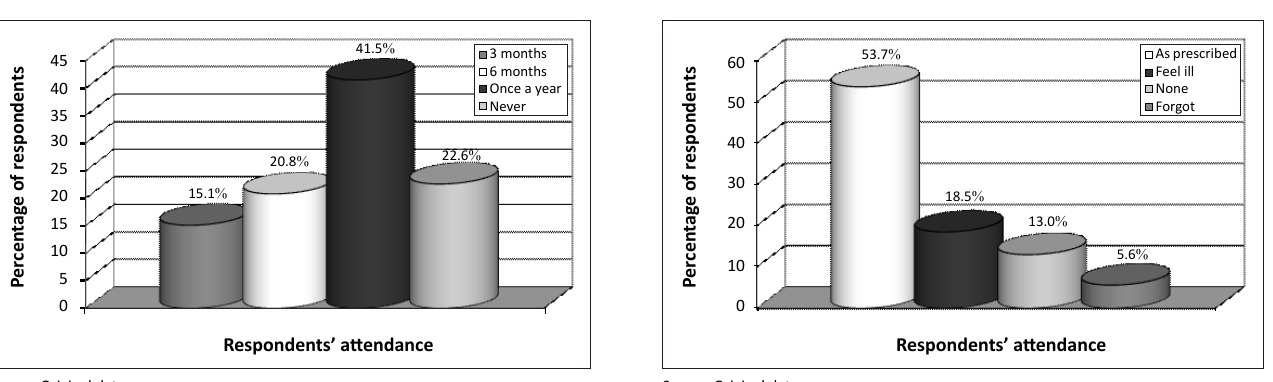
FIGURE 1: Respondents’ annual attendances of medical check-ups per annum ( n = 53).